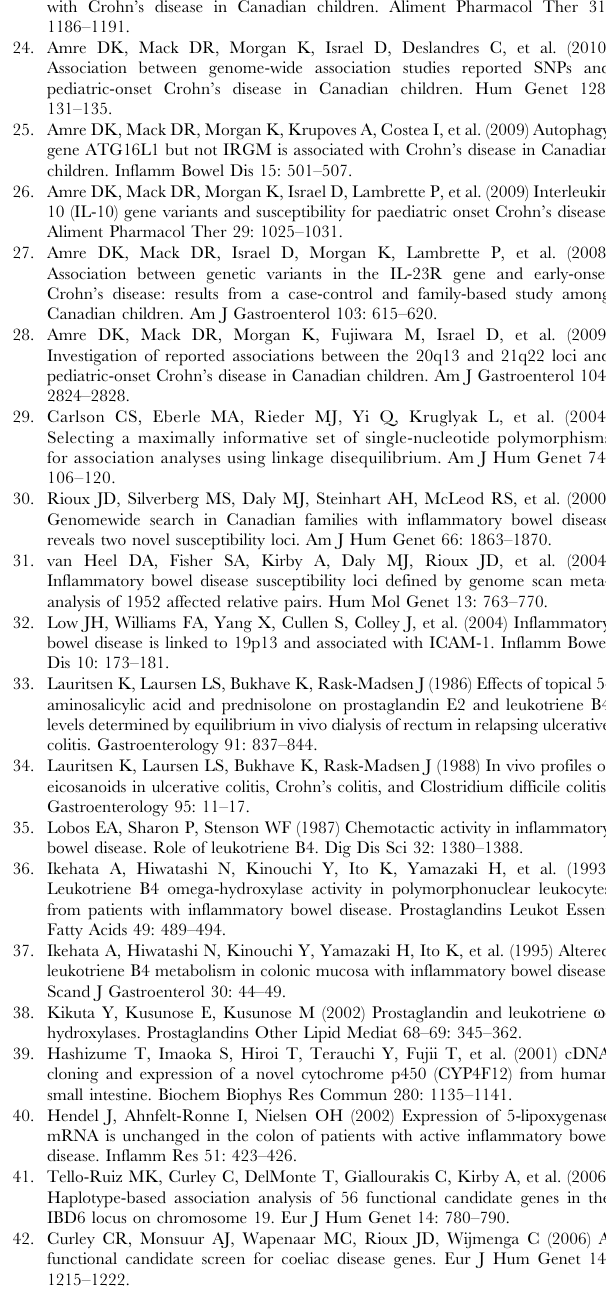
Table S1 Primers used for genotyping the ALOX5 , CYP4F3 and CYP4F2 SNPs.